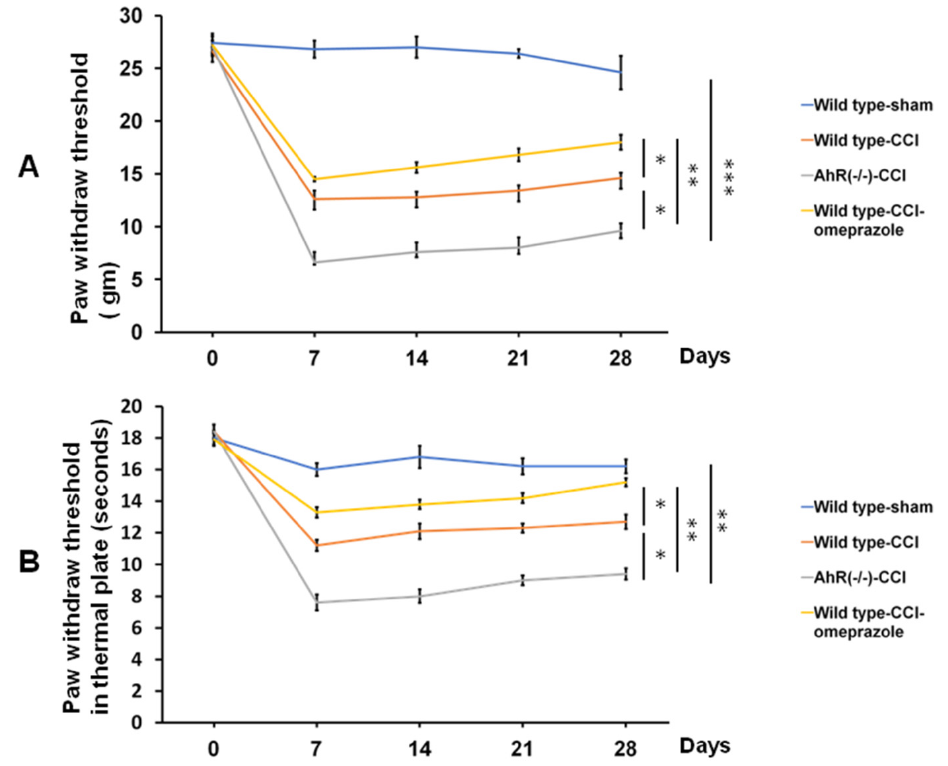
Figure 4. The assessment of neurobehavior by Von Frey and hot plate tests in CCI allocated to different treatment groups related to different time points. ( A ) Quantitative analysis of the paw withdrawal threshold by a Von Frey test in the different treatment groups related to different time points. ( B ) Quantitative analysis of paw thermal withdrawal threshold by hot plate tests in the different treatment groups related to different time points. N = 6, Wild type-sham; Wild type-CCI; AhR ( − / − )-CCI; Wild type-CCI-omeprazole: see text. *: p < 0.05; **: p < 0.01; ***: p < 0.001. The Catwalk gait analysis is a useful measurement of altered gait after CCI [21]. Our results of the Catwalk test are shown in Table 1. After CCI, we found shortened standing time (stand phase in msec), and deletion of AhR further reduced standing time, while omeprazole attenuated the effects. In the swing phase analysis, we found the opposite results. The data of printed area, single stance, and maximum contact maximum intensity showed the same trends as in the standing